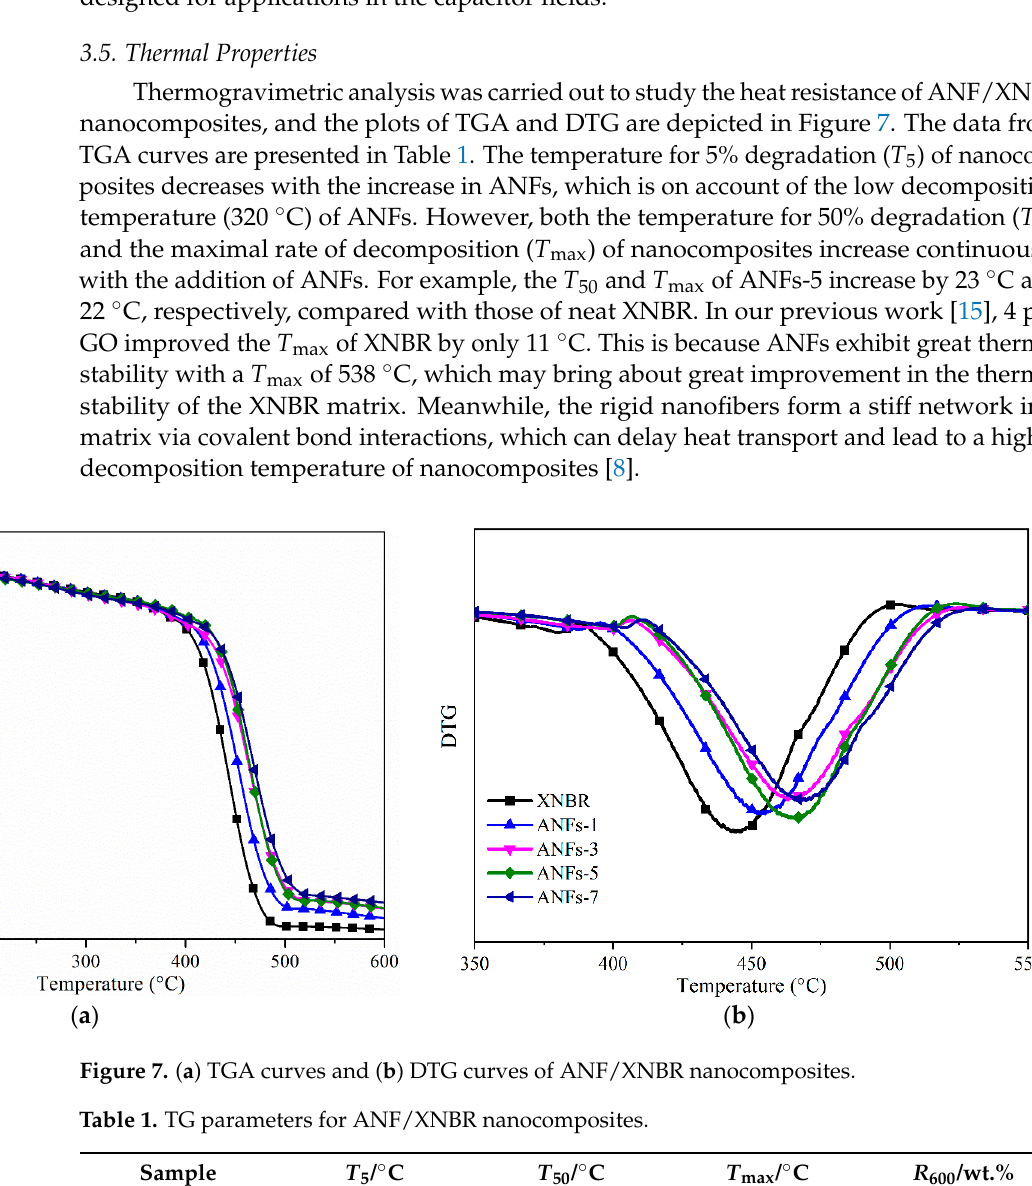
Figure 6. Dependence of ( a ) dielectric constants and ( b ) dielectric loss on the frequency of